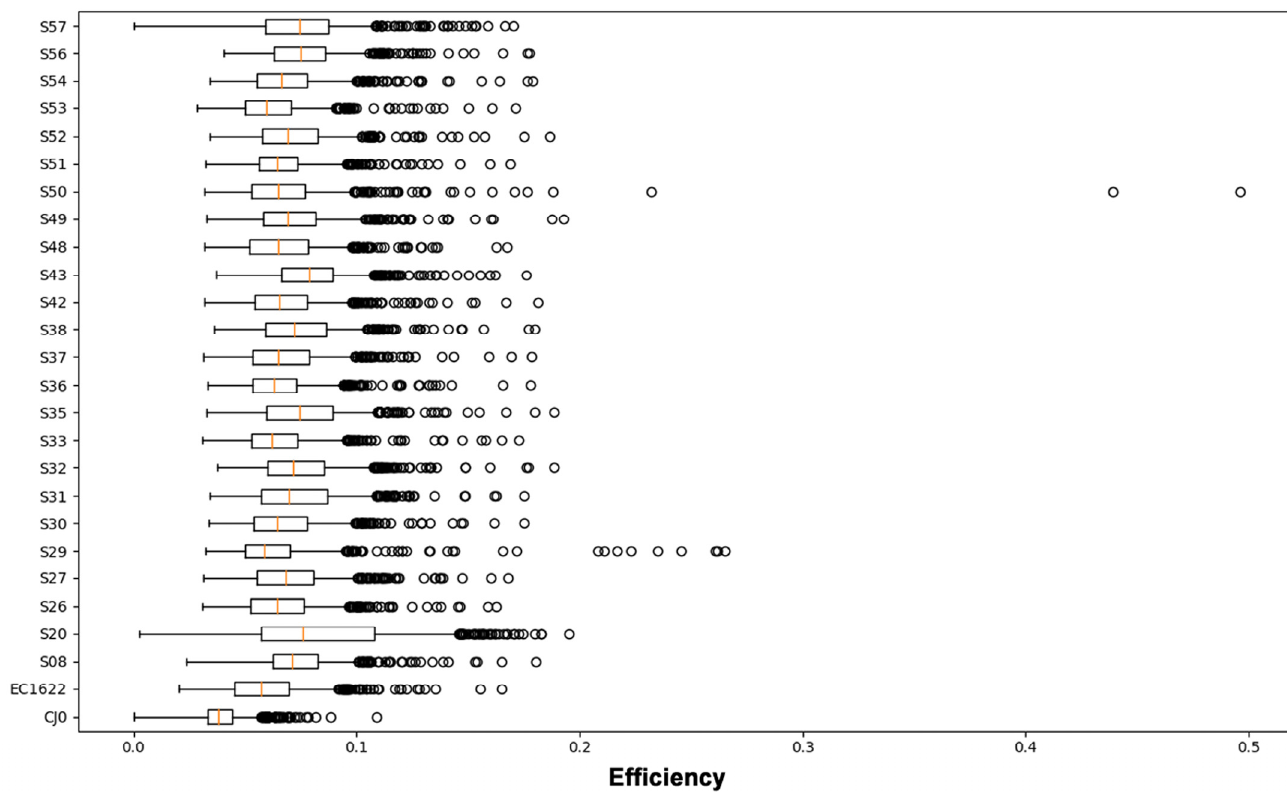
Figure 3. Boxplot representation of the distribution of Shannon Entropy Efficiency values in the genome segment from nt. 2390 to nt. 3242, each position individually contributing. For each sample, the average, 25–75% interquartile range, SD interval and single high-range outlier values are shown. Average value is termed as ‘ α -diversity’ index. For interpretation of data, see also Figure 2.